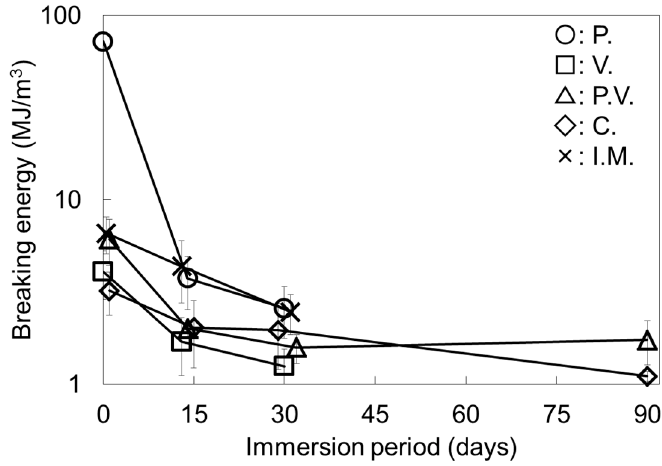
Figure 10. Comparison of the changes of the breaking energy of the five test piece types. Average ± S.D., n = 5.